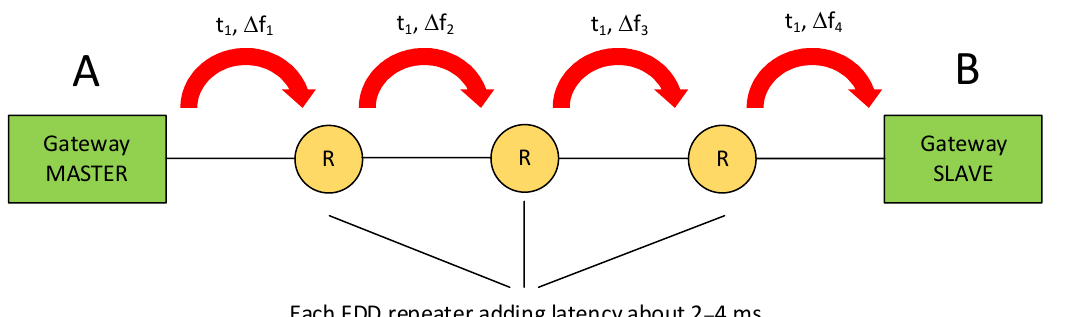
Figure 2. Data transmission from point A to point B using repeaters (R) in a TDD scenario.